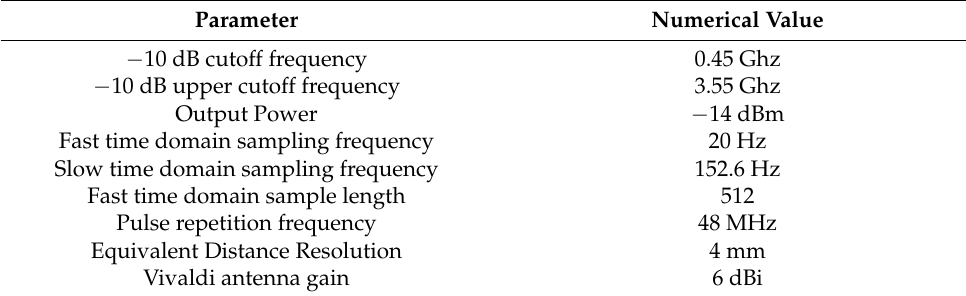
Table 1. Parameters of UWB radar system.